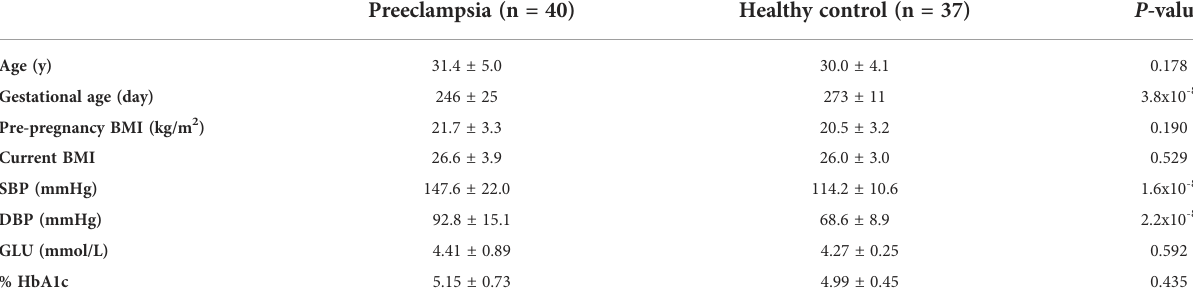
TABLE 1 Basic characteristics of the preeclampsia patients and healthy controls included in this